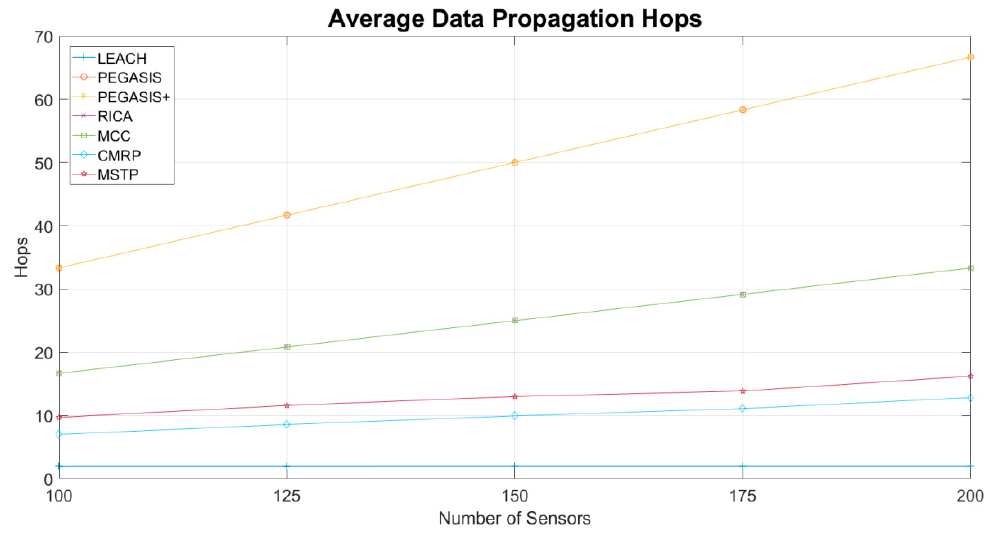
Figure 6. Average number of data propagation hops.